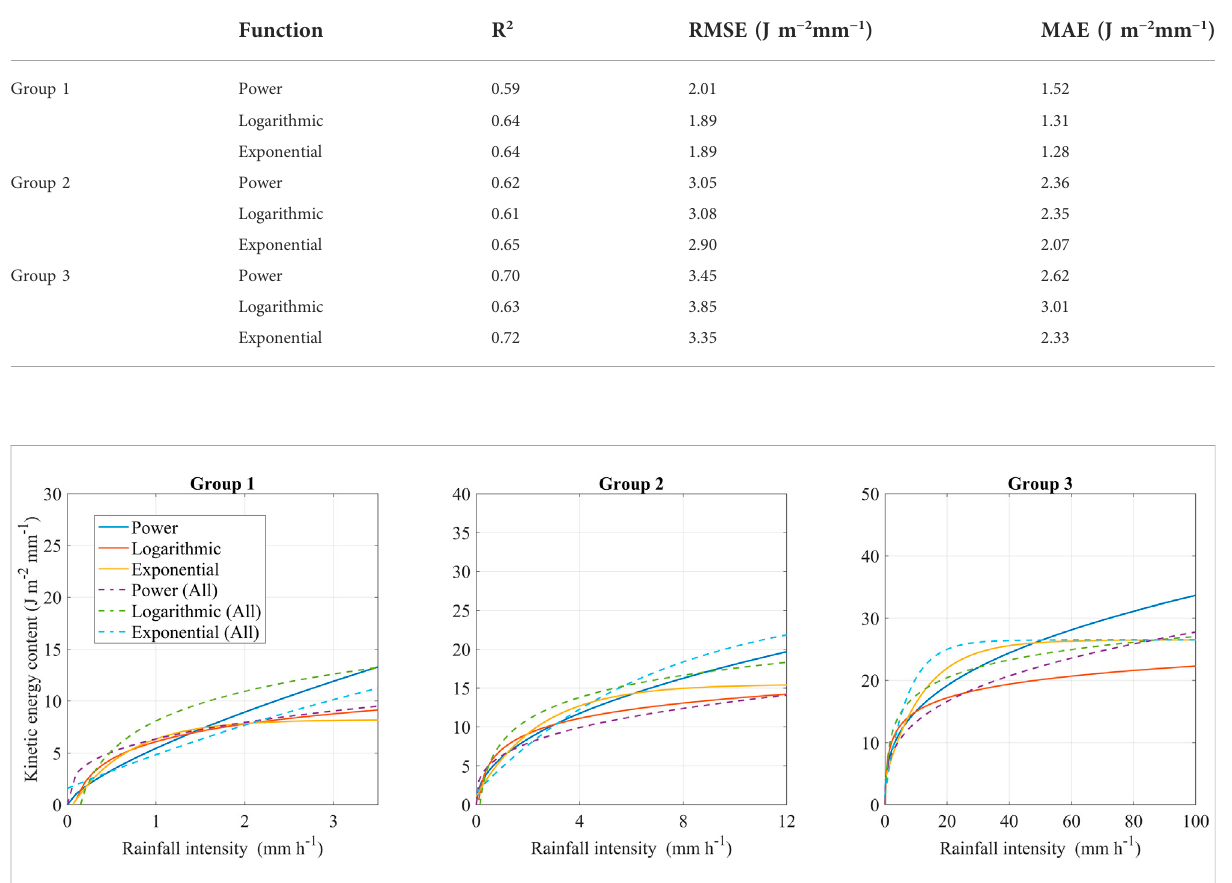
FIGURE 8 Comparison of KE con estimations from equations derived from 37 events (dotted lines) and grouped rainfall events (solid lines). The position of dottedlineshigherthanthatofsolidlinesindicatestheuncertaintyofKE con estimationbetweenthetwoapproaches.Theequationsfromgroup1are appropriate for low rainfall intensity, whereas those from group 2 are suitable for high rainfall